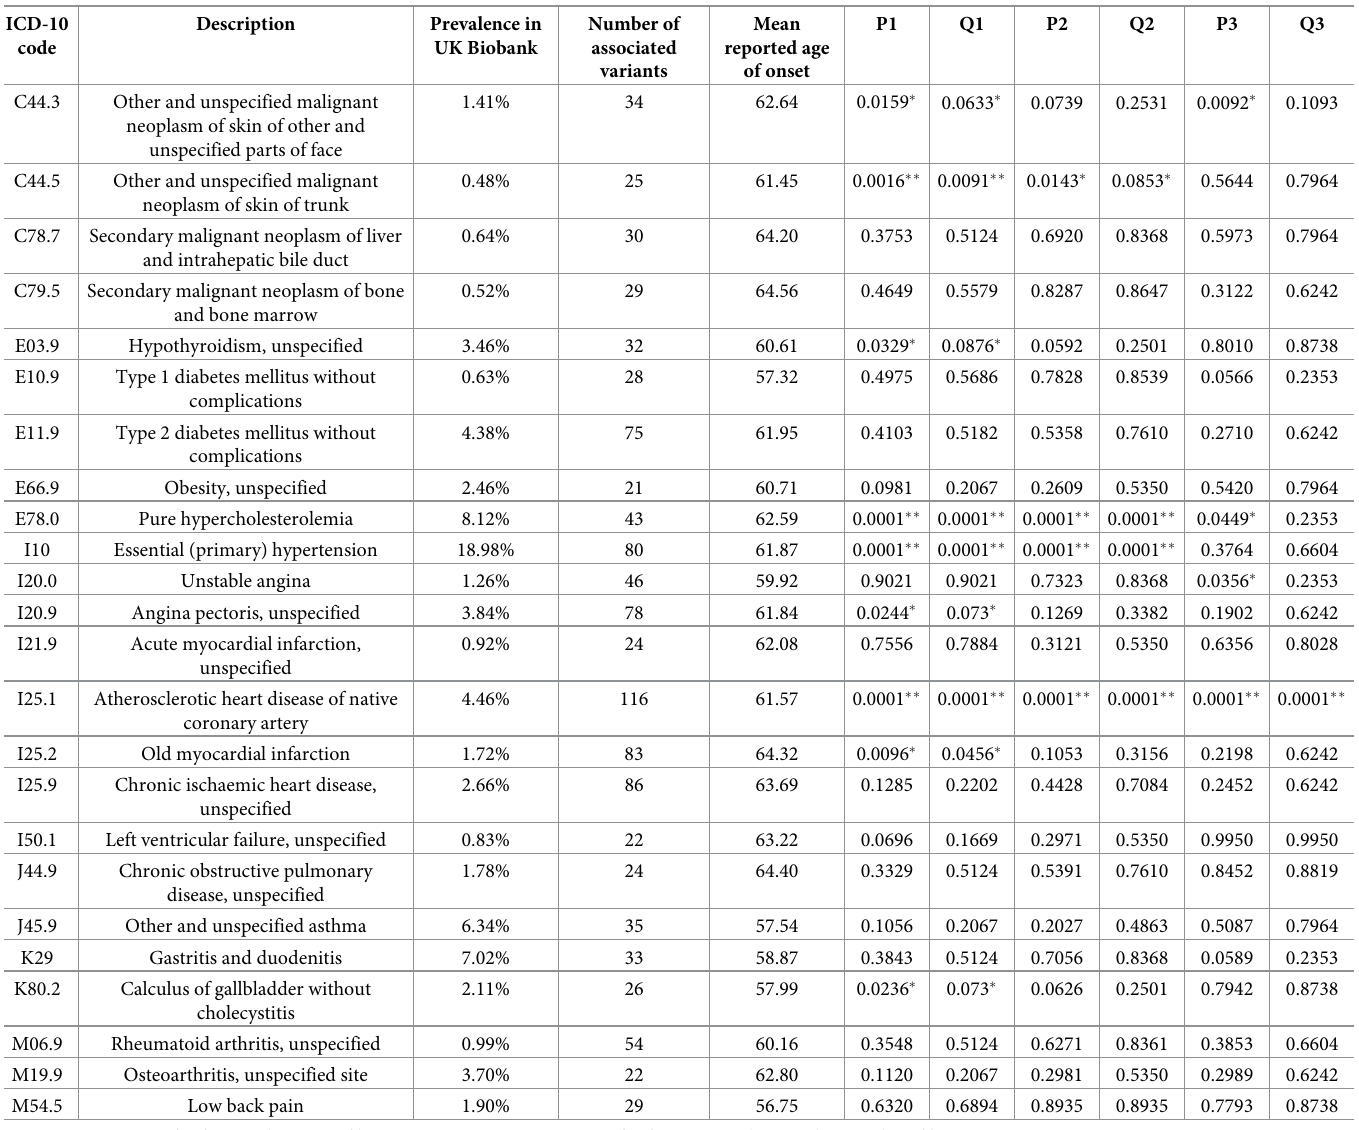
Table 1. Summary of evidence for age-varying genetic risk by